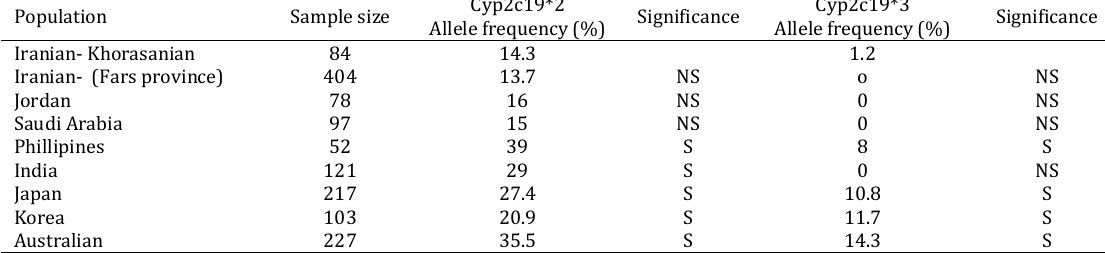
Table 5. Frequency of CYP2C19*2 and *3 alleles in other Asian populations versus Khorasanian population